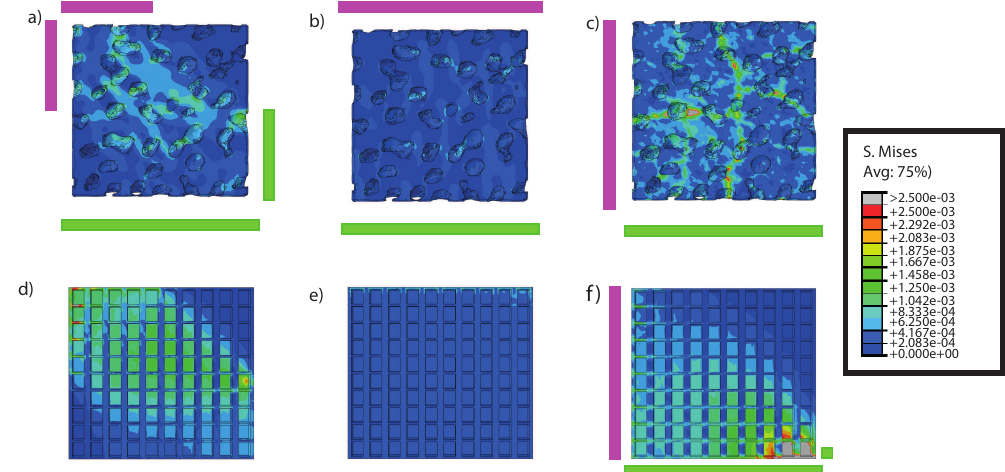
Figure 7. The von Mises stress patterns on the biological model (a, b, c) and the compartment model (d, e, f) in different loading situations; the original (mixture of both shear and compressive loads, a , d ); compressive load (b, e) and the shear load (c, f) . The different load situations (pink box) are shown on the biological model as well as the constraints (green boxes). The shear load for the compartment model was set up slightly differently and hence the loading setup is displayed on the model (f) . Units = Nµm − 2 .